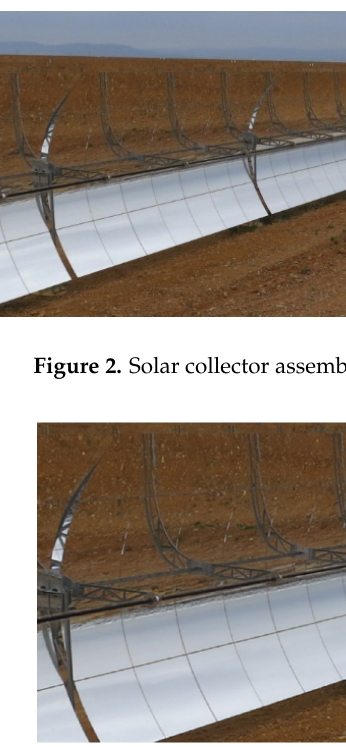
Figure 3. Solar collector element (SCE) with 28 mirrors and three absorber pipes.